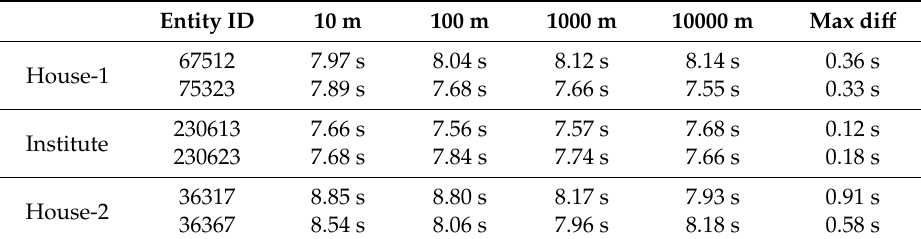
Table 8. B-Rep producing time (20,000 repetitions) for unbounded half